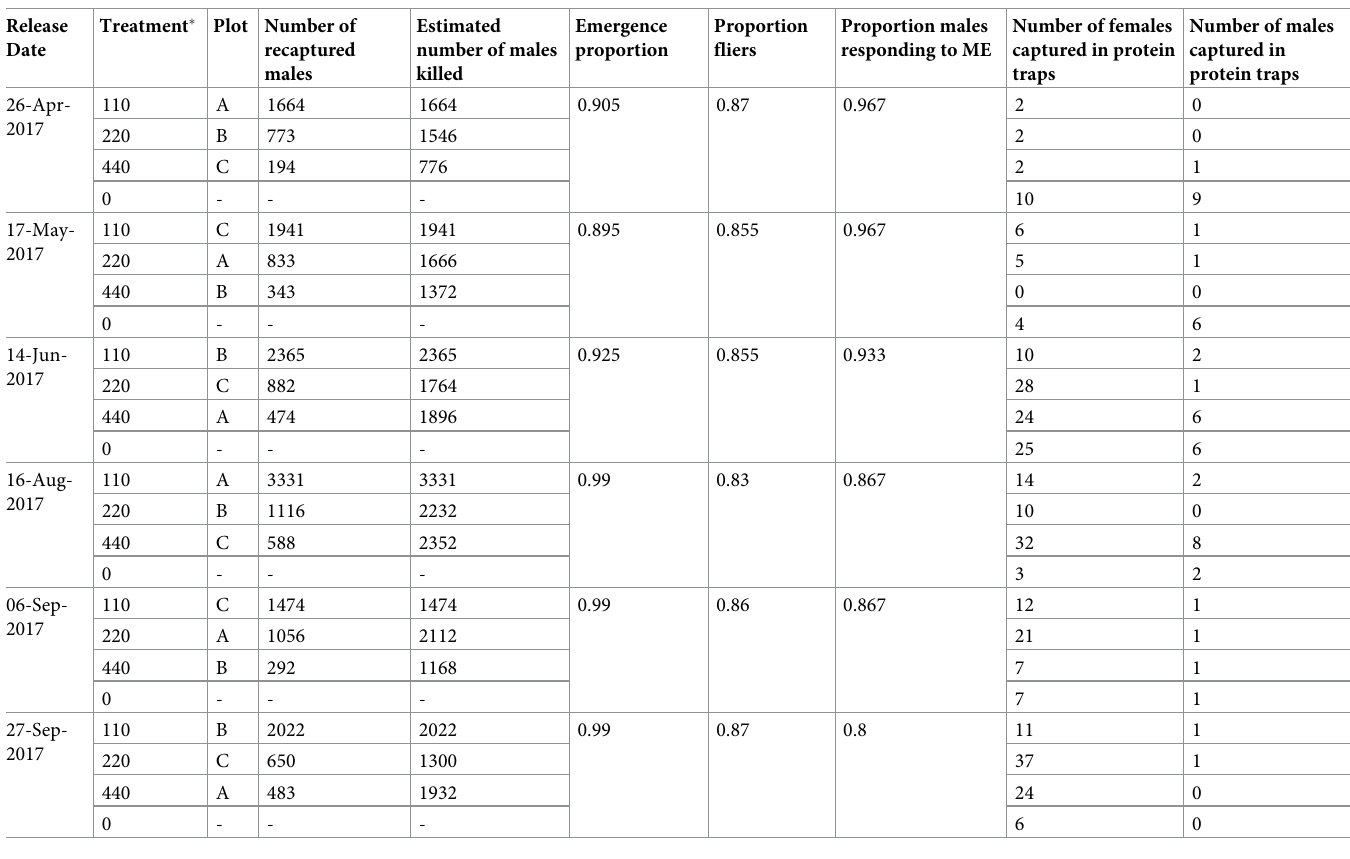
Table 3. Release, recapture and quality control data for aged (14d old) replicates. Estimated number released in each plot based on pupal volume and an even sex ratio was 6,300 each of males and females. Considering the emergence proportion, proportion responders to ME, and proportion of fliers, the estimated number of males avail- able for capture per plot varied between 4,488 and 4,797 across